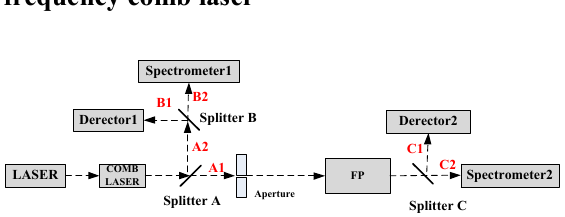
Figure 4. Schematic of measuring FP transmittance curve using frequency comb light